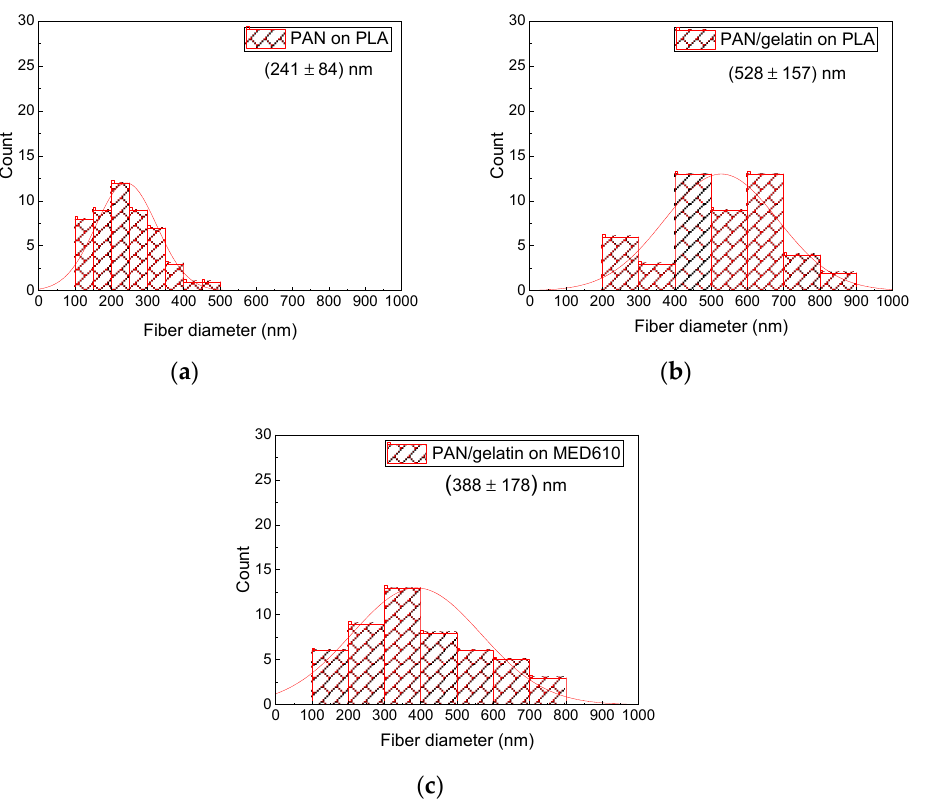
Figure 15. Diameter distribution of ( a ) PAN nanofiber mats on PLA object; ( b ) PAN/gelatin nanofiber on PLA object and ( c ) PAN/gelatin on MED610 object.